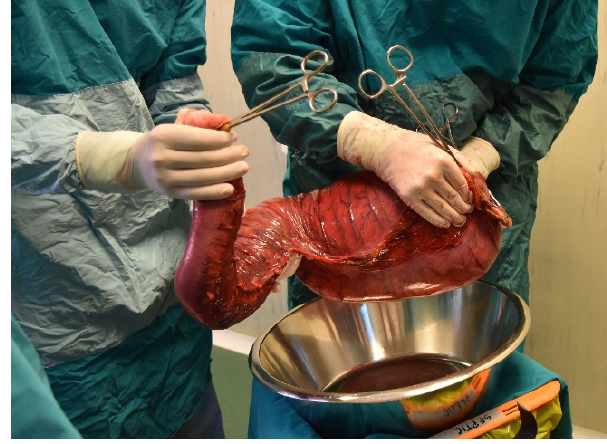
Figure 11. Intraoperative picture. Colon resection specimen.